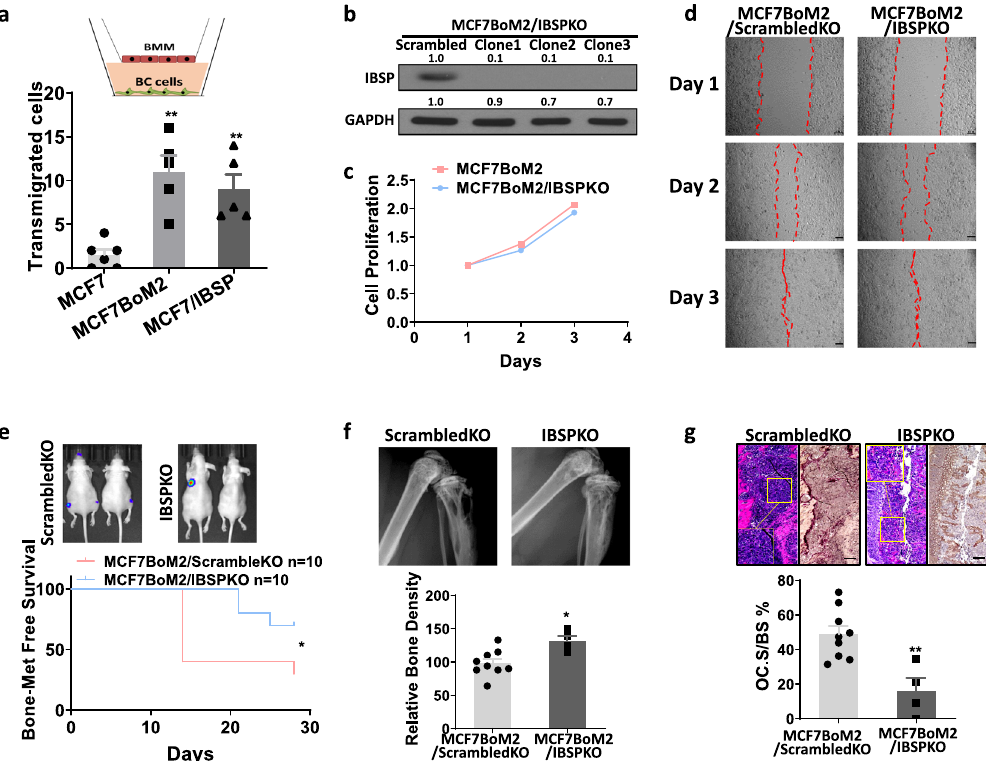
Fig. 5 ER + breast cancer cells secrete IBSP to recruit osteoclast precursors. a Trans-well migration assays were performed to measure the migration ability of BMMs towards breast cancer cells. BMMs were seeded on the luminal side and breast cancer cells (MCF7, MCF7BoM2, and MCF7/IBSP) were seeded on the abluminal chamber. Data are presented as mean values± SEM. b CRISPR-Cas9 mediated knockout of IBSP in MCF7BoM2. Three knockout clones were con fi rmed by western blot. The band intensity was quanti fi ed and normalized to that of control (left panels). c The selected clones were mixed and designated as MCF7BoM2IBSPKO. Cell proliferation was measured for MCF7BoM2 and MCF7BoM2/IBSPKO by MTS assay. A two-sided student ’ s t - test was performed on day 3 and p = 0.0496 ( n = 3 vs 3). Data are presented as mean values ± SEM. d Cell migration ability of MCF7BoM2 and MCF7BoM2/IBSPKO was measured by wound-healing assay. Scale bar, 100 µ m. e MCF7BoM2/ScrambledKO and MCF7BoM2/IBSPKO (500,000/0.1 ml PBS) were transplanted into female nude mice via intracardiac injection. The growth of bone metastasis was monitored by measuring the luciferase activity by IVIS Bioimager, and the Kaplan – Meier analysis was done for bone metastasis-free survival ( p = 0.0496, HR = 4.101). f The tumor-bearing bones were imaged by X-ray, and the relative bone densities were quanti fi ed by ImageJ ( p = 0.0124, n = 9 vs 4). Two-sided student ’ s t -tests were performed. Data are presented as mean values± SEM. g OC surface relative to the bone surface was calculated and compared after TRAP staining. H&E staining of the same fi eld was shown together with the TRAP staining ( p = 0.0036, n = 9 vs 4). Two-sided student ’ s t -tests were performed. Data are presented as mean values ± SEM. Scale bar, 100 µ